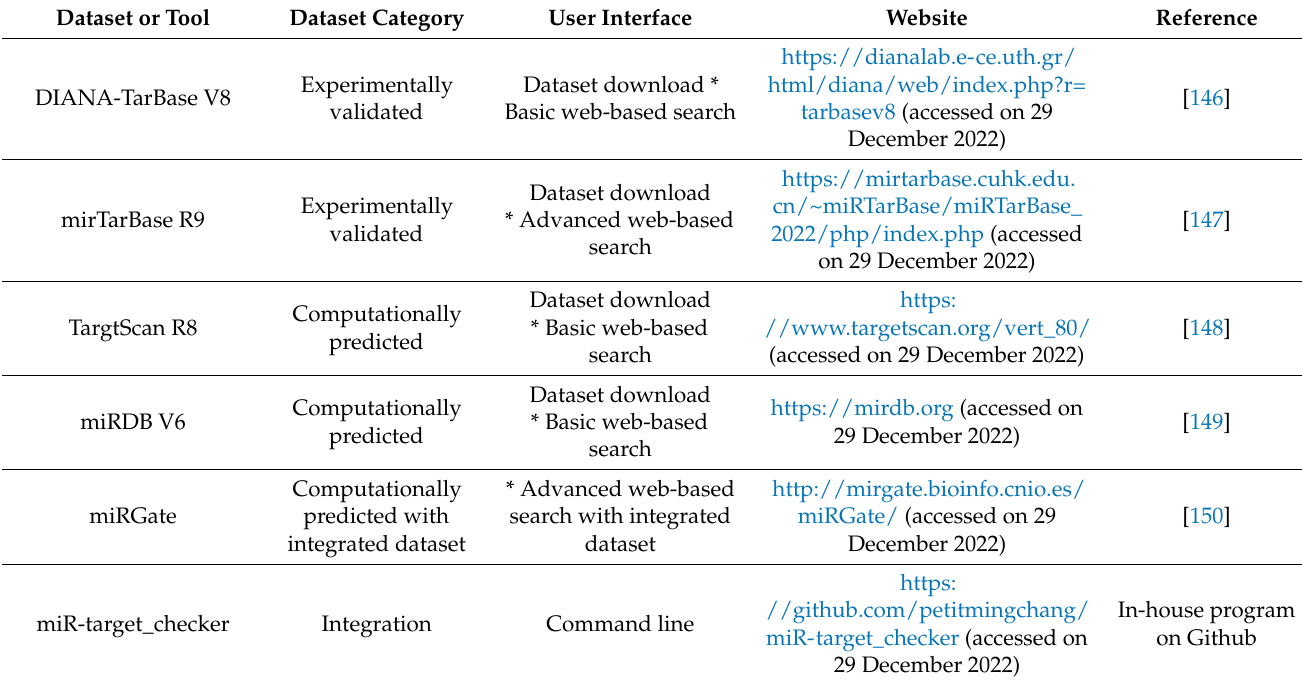
Table 4. List of microRNA (miRNA)-target prediction datasets and